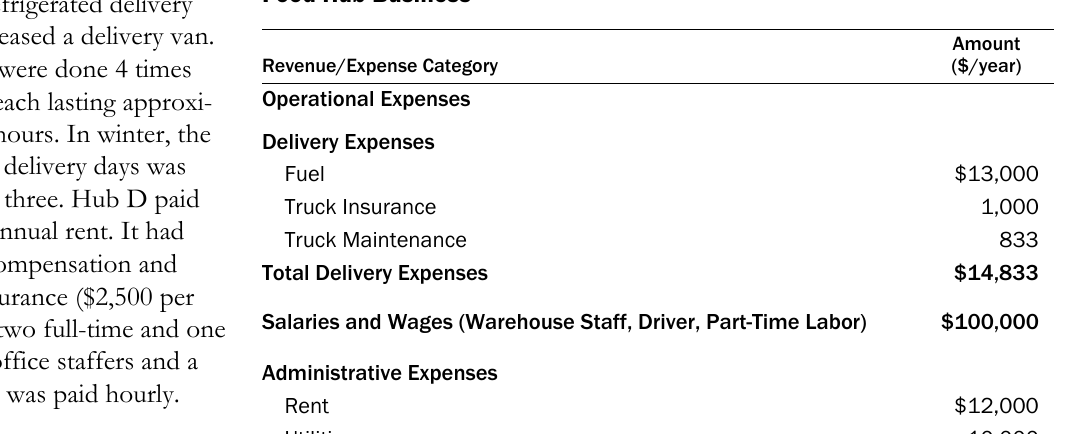
Table 2. Estimated Minimally Required Annual Operational Budget for a Food Hub